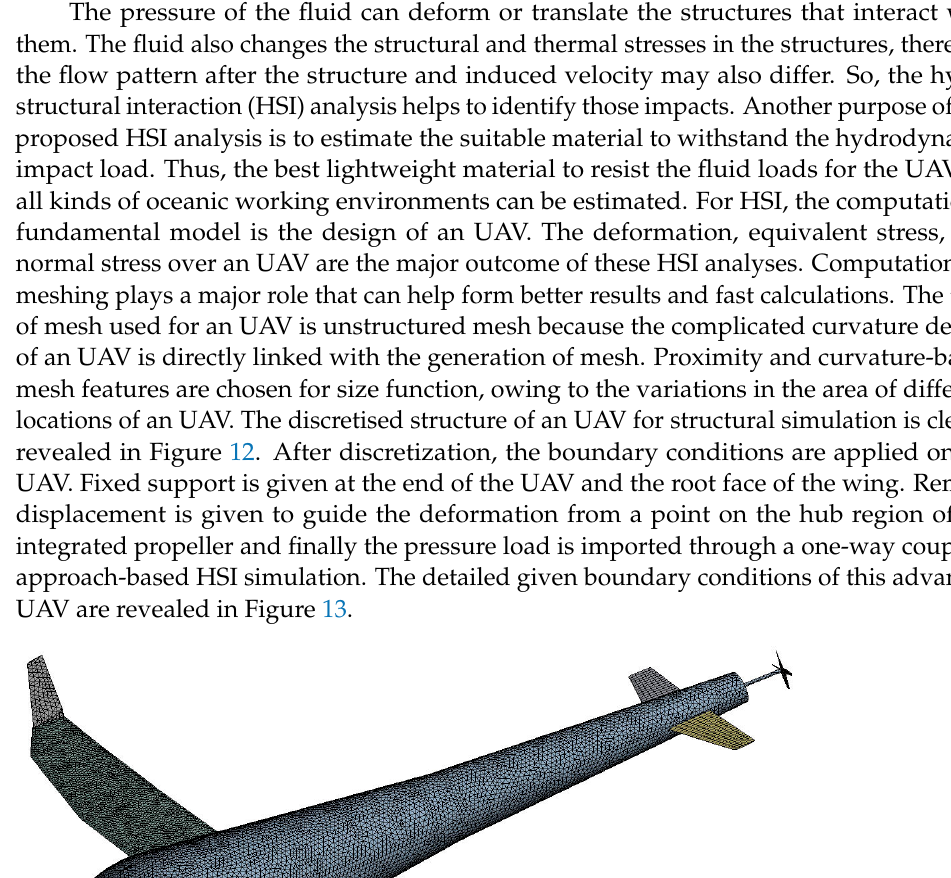
Figure 13. Boundary conditions imposed under HSI environment. Grid Convergence Study—II From Figure 9, it is observed that mesh case-3 performed better than other cases based on its low compositional elements and high reliability outcomes. In previous mesh studies, mesh case-3 had an unstructured fine curvature with area proximity. Figure 14 shows the comparative mesh outcomes of the second grid convergence test. From Figure 14, it is observed that mesh case-2 performed better than other mesh cases based on the equivalent stress-based outcomes of hydro-structural computation. Mesh case-2 is un- structured fine proximity. Hence the same shortlisted mesh cases are extended for all other simulations. The complete mesh data for this second study are listed in Table 13.